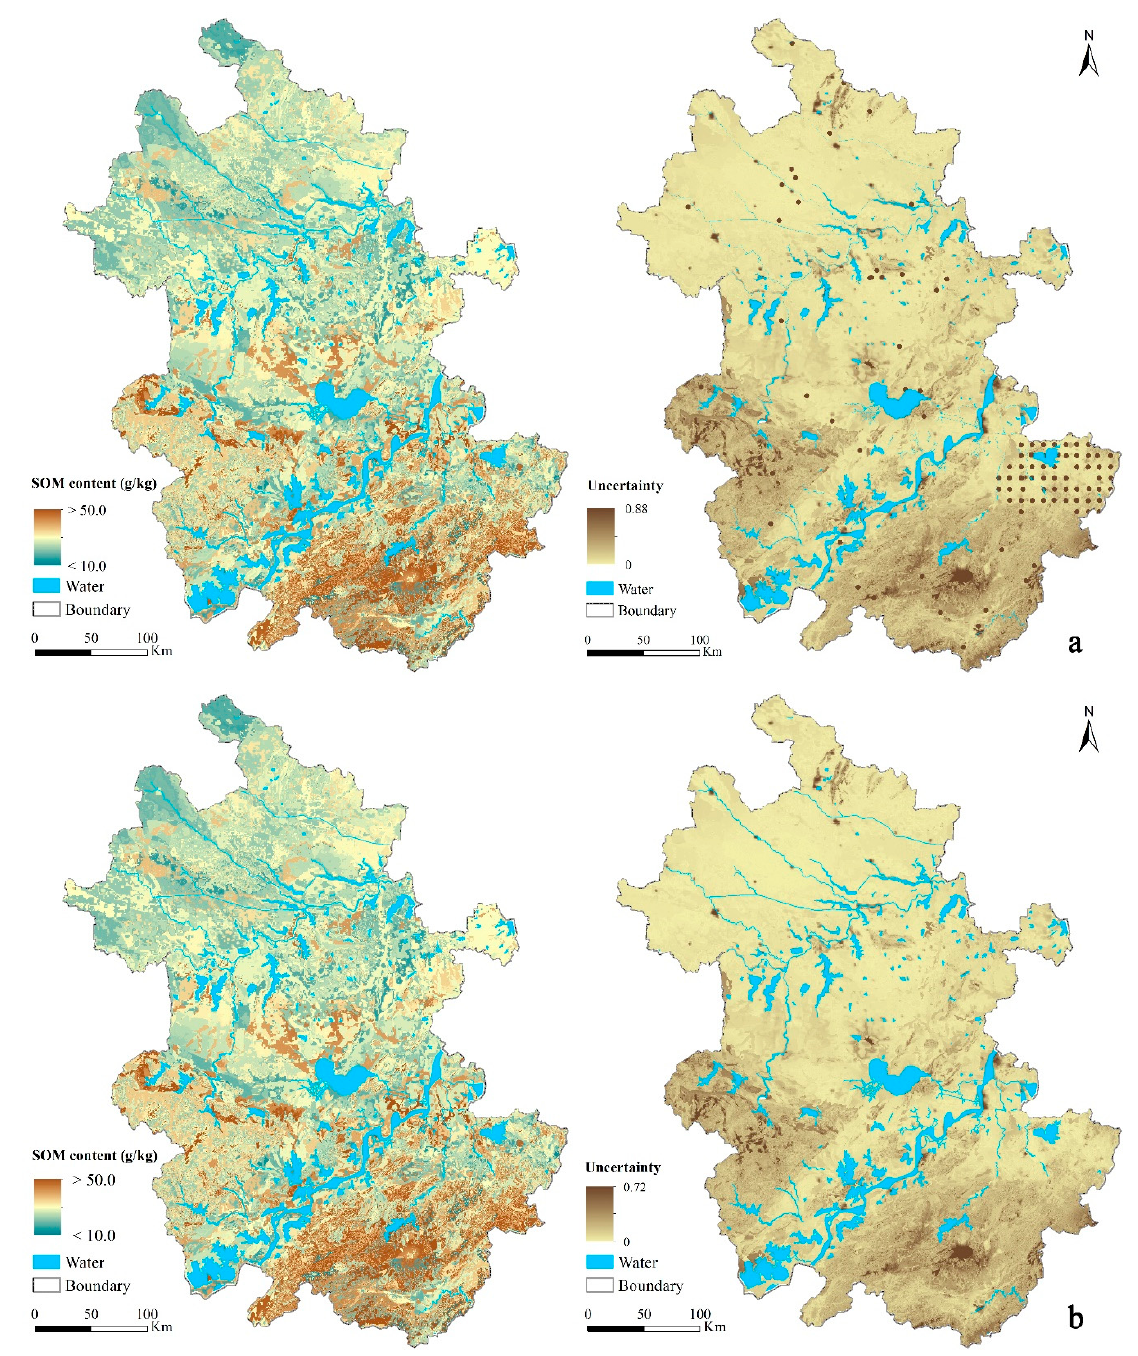
Figure 5. Cont. Figure 5.